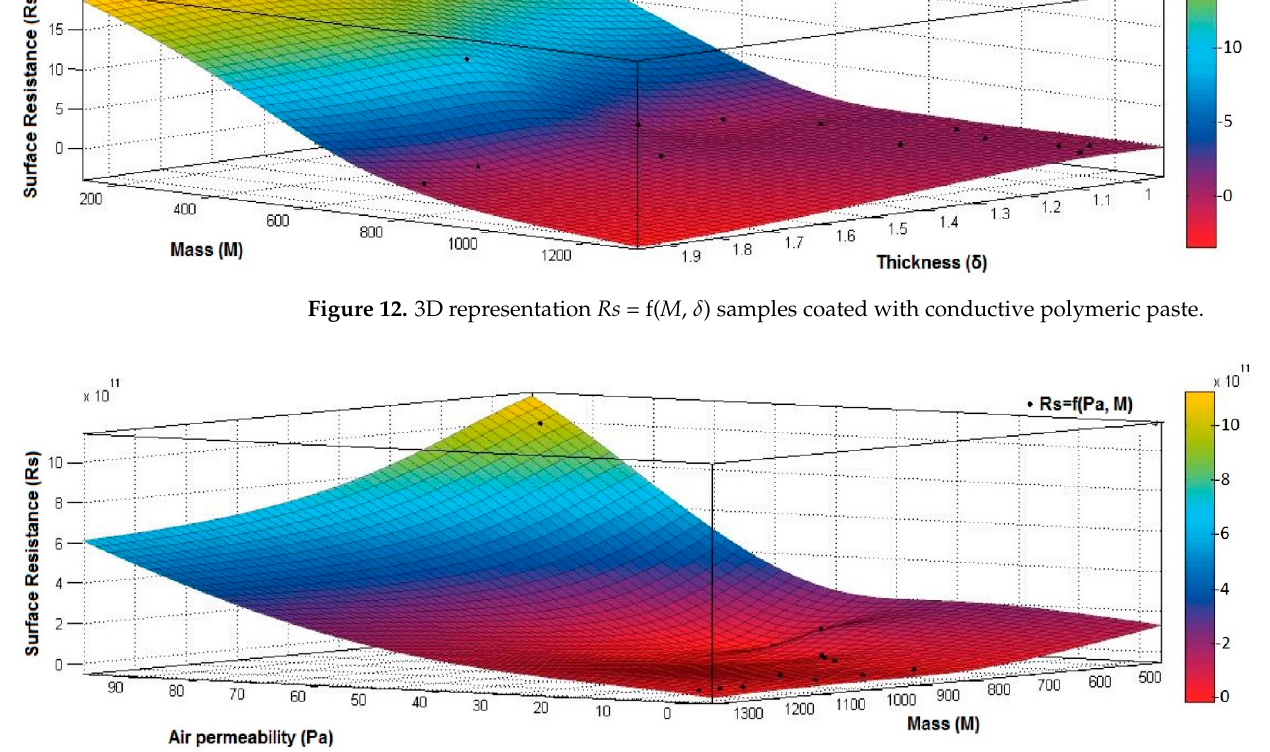
Figure 13. 3D representation R s ( Pa , M ) samples coated with conductive polymeric paste.